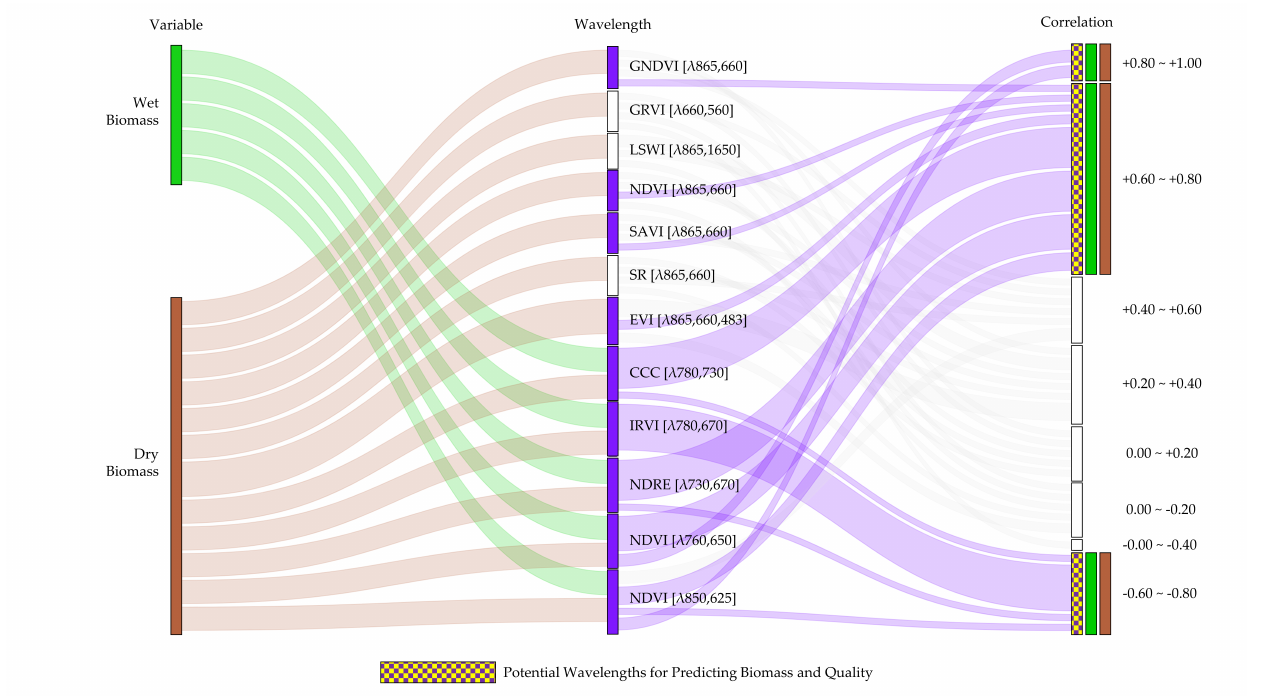
Figure A7. Sankey diagram illustrates the vegetation indices most correlated with alfalfa biomass and quality traits. The flow chart intuitively displays bars and paths drawn in proportion to the amount of information used. The larger the bars, the more times this information has been used. Colored pathways assign the connections between alfalfa biomass and quality traits and its usage in remote sensing data (i.e., wavelengths or vege- tation indices) as well as its response to the strength of the correlation. When wavelength or vegetation indices have the potential to be used to establish a relationship with biomass and quality traits, they are marked. The colors of each correlation bar are linked to the biomass and quality traits. When it is white, it is because it has no potential to be used. However, when the bar is colored and checkered, it indicates that although it has not been used to study its relationship with quality, it has the potential to predict it assuming its correlation with